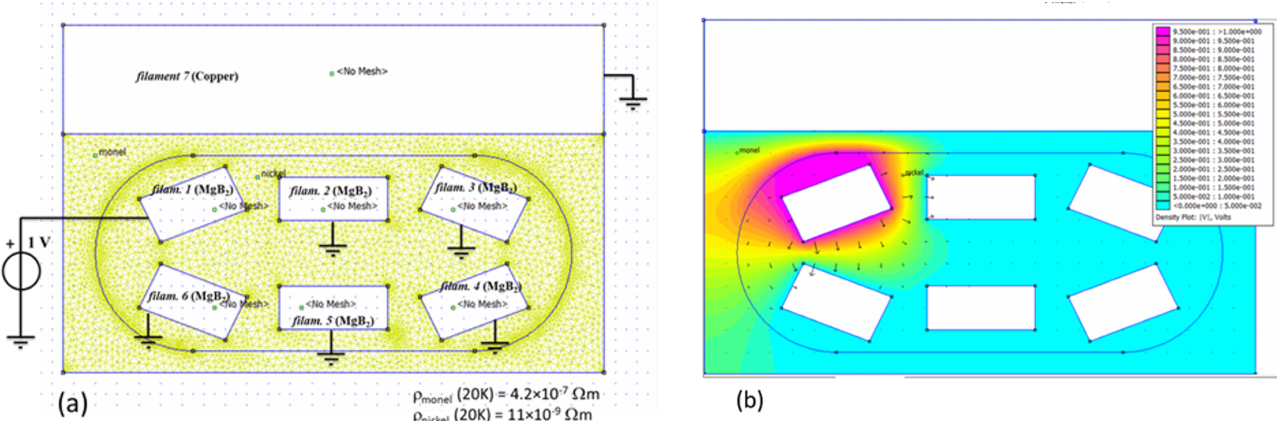
Figure A2. ( a ) Model for calculating the conductance between filament 1 of the MgB 2 conductor and all the others. ( b ) Results of voltage and current distribution.